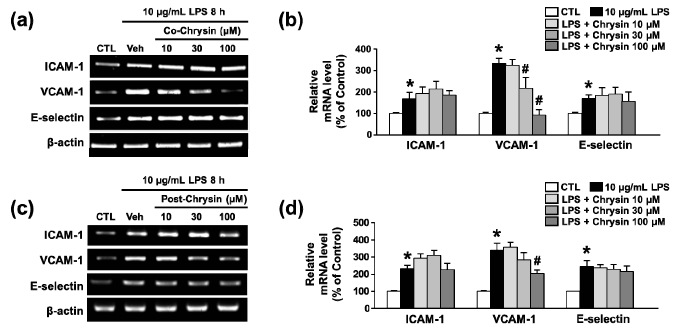
Figure 5. The therapeutic effect of chrysin on LPS-induced adhesion molecule mRNA expression in bEnd.3 cells. ( a ) Cells were co-treated with chrysin (10–100 μ M) and 10 μ g/mL LPS for 8 h; ( b ) the levels of ICAM-1, VCAM-1, and E-selectin mRNA were evaluated by RT-PCR and quantified by densitometry; ( c ) cell were post-treated with chrysin (10–100 μ M) at 4 h after administration of 10 μ g/mL LPS; and ( d ) the levels of ICAM-1, VCAM-1, and E-selectin mRNA were evaluated by RT-PCR and quantified by densitometry. β -actin was used for normalization. Mean ± SEM, * p < 0.05 vs. control and # p < 0.05 vs. 10 μ g/mL LPS alone, n = 3.